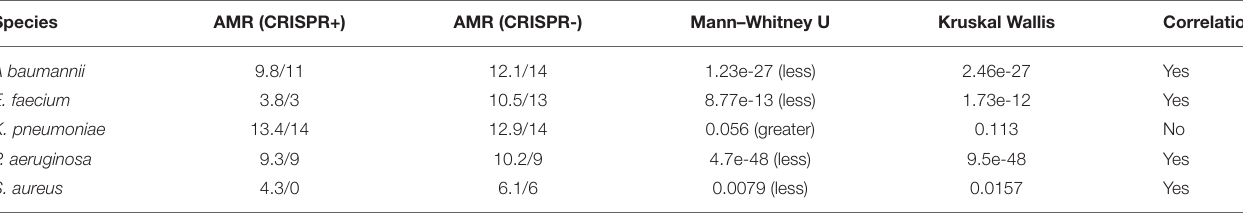
TABLE 3 | Correlation (or lack of correlation) between AMR genes and CRISPR–Cas systems. Species AMR (CRISPR+)